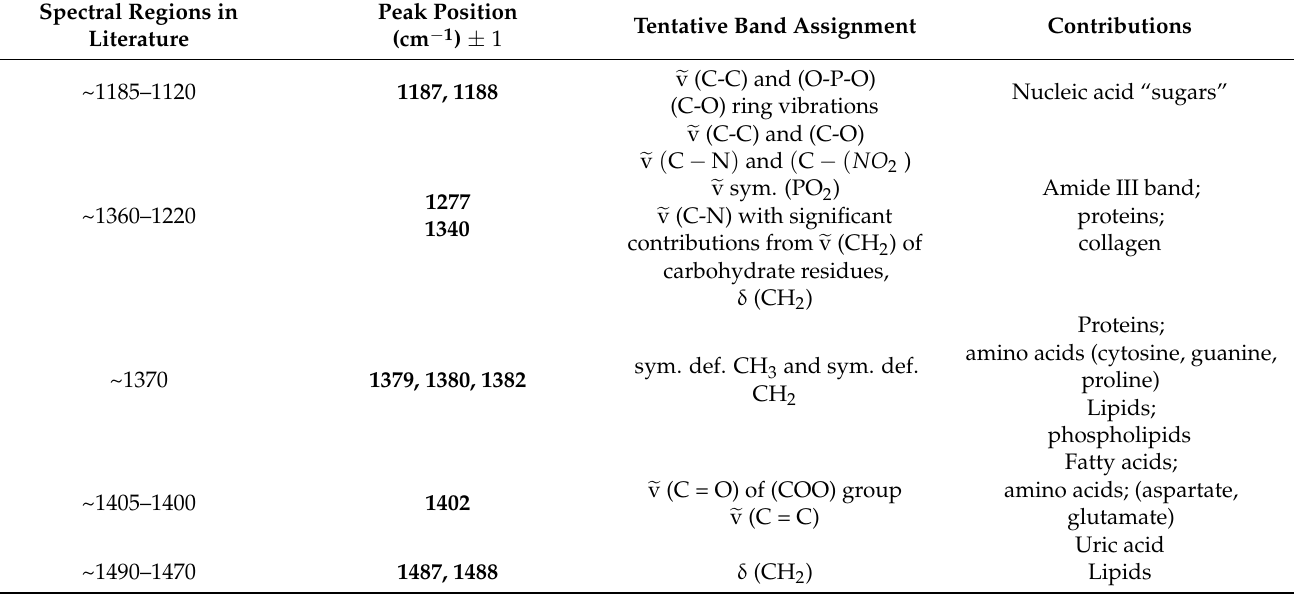
Table A3. Biochemical tentative assignments of the most discriminant wavenumbers selected by SELECT-LDA in the classification approach aimed at achieving a direct discrimination between de- mentia associated with both analysed pathologies (PD-related dementia and Alzheimer’s